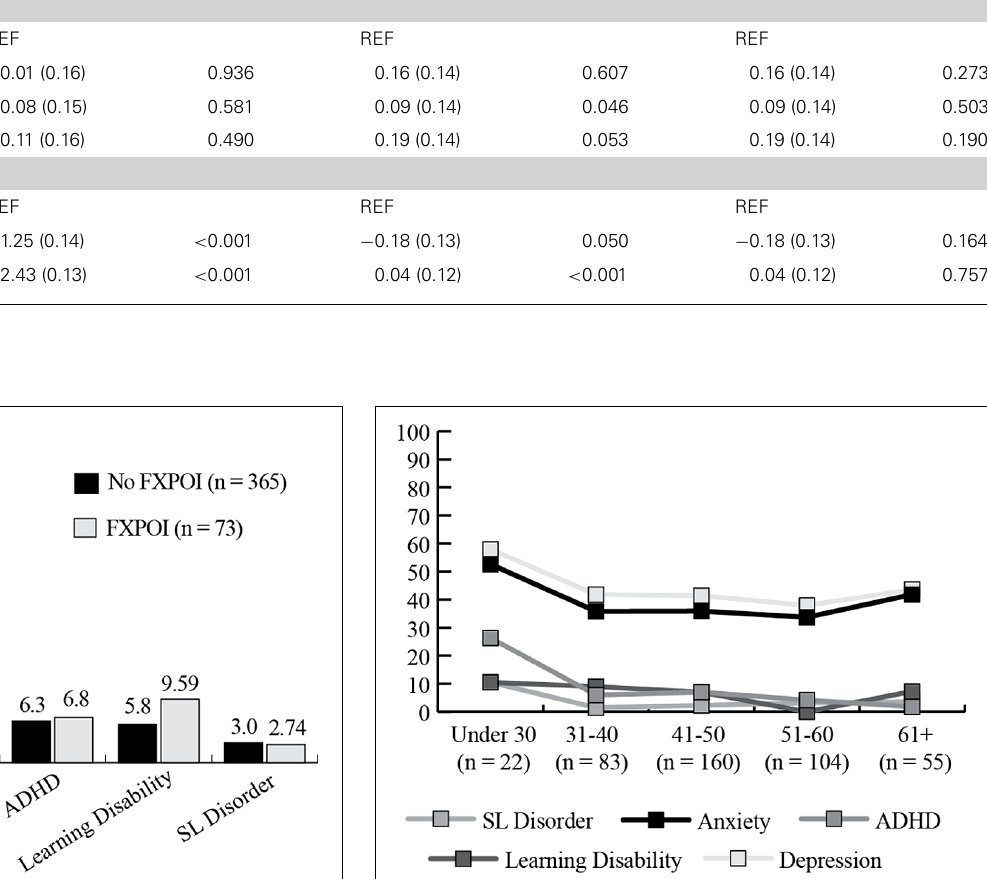
Results of the regression model showed that respondents with lowerfamilyincome,achildwithmoreaggressionissues,andmore co-occurring emotional conditions reported more daily physical health symptoms (see Table 2